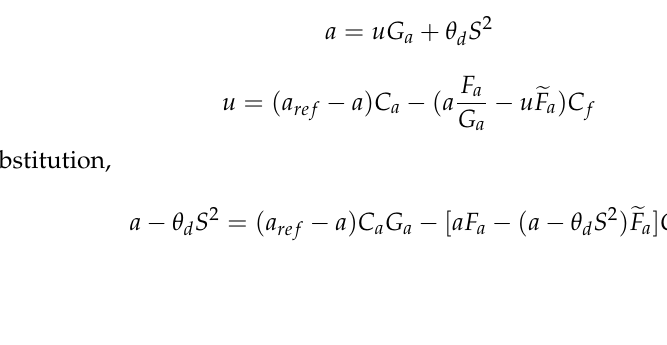
Figure 2. The basic principle of the complementary filter. H high − bandwidth and H low − bandwidth are respectively the transfer characteristics of the high-bandwidth and low-bandwidth sensors. C ( s ) is a designed open-loop filter. S in and S out are respectively the real motion status and the fusion output.